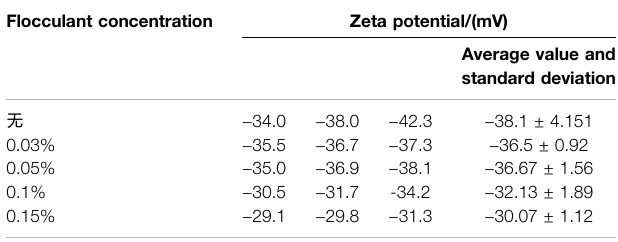
TABLE 9 | Effect of organic fl occulant on Zeta potential of PEM drilling fl uid. Flocculant/(0.05%) Zeta potential/(mV)